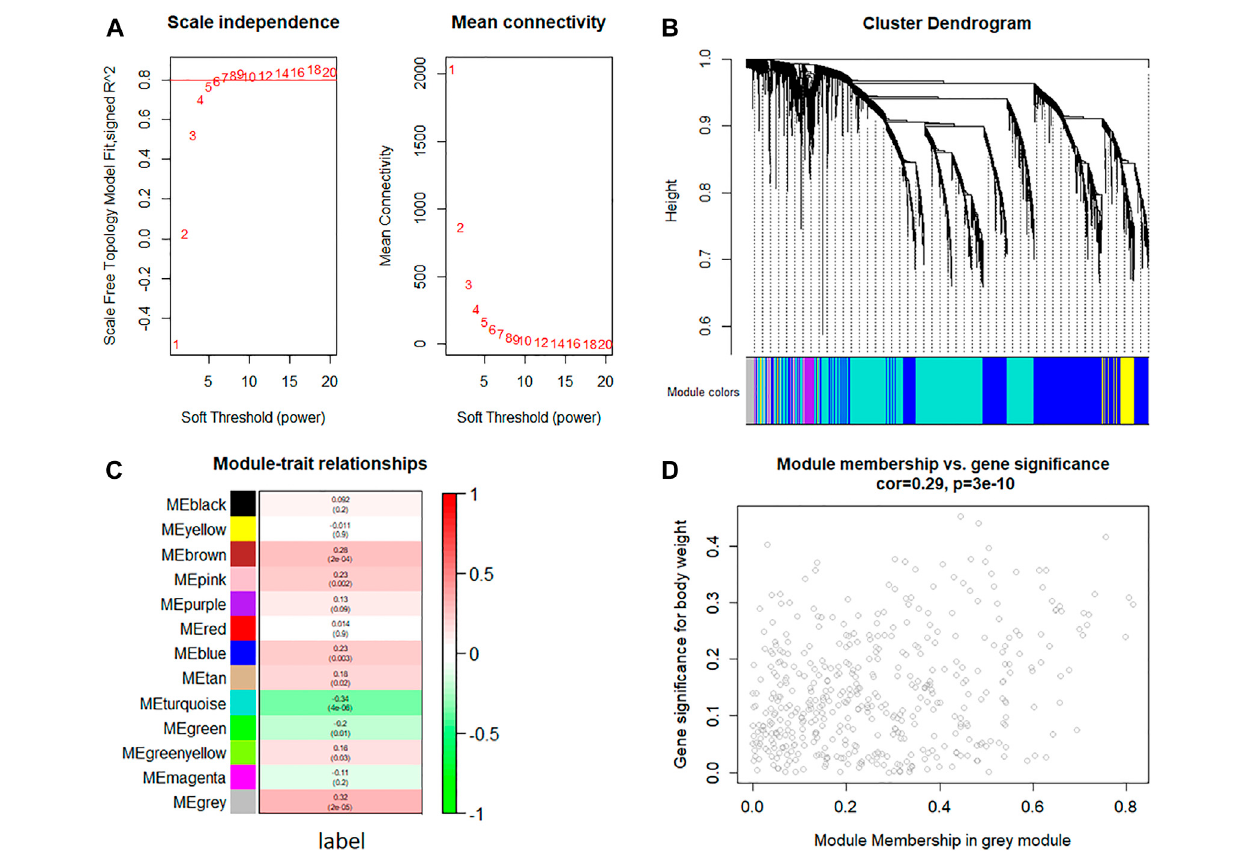
FIGURE 3 | Weighted gene co-expression network analysis of gene expression between malignant and benign thyroid nodules. (A) Analysis of the scale-free topology fi tindexandthemeanconnectivityforvarious softthreshold powers ( β )forthegenes, (B) dendrogram ofallexpressed genesclusteredbasedonadissimilarity measure, (C) heatmap of module – trait relationships depicting correlations between module eigengenes and phenotypic traits (the label of malignant and benign thyroid nodules).Numberscorrespond tothecorrelationandthe p -valueinparentheses. Thedegree ofcorrelation isillustrated withthecolorlegend,and (D) identi fi cation of hub genes using the scatterplot of module eigengenes in the gray co-expression module.